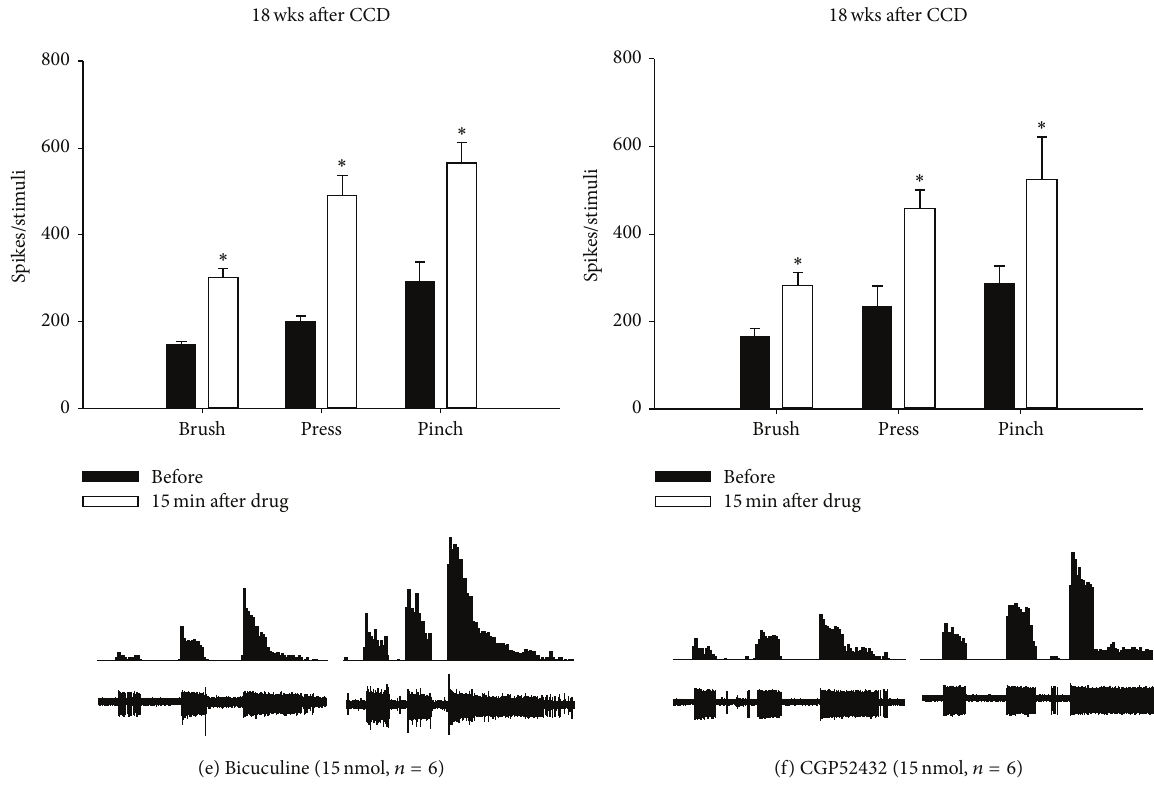
Figure 5: The effects of inhibition or activation of spinal GABA receptors on WDR neuronal activity following CCD. In sham-operated animals, topical application of bicuculline ((a), 15 nmol) or CGP52432 ((b), 15nmol) enhanced the activity of spinal WDR neurons evoked by brushing, pressing, and pinching stimuli. On 1 week after CCD, topical application of muscimol ((c), 5 nmol) or baclofen ((d), 25 nmol) attenuated the enhanced evoked activity of WDR neurons. On 18 weeks after CCD, bicuculline ((e), 15nmol) or CGP52432 ((f), 15nmol) led to an increase in evoked activity of WDR neurons. Data were expressed as the mean number of spike discharges generated from a single WDR neuron evoked by three types of 10s mechanical stimuli. Below each bar graph, examples of extracellular recordings of stimulus-evoked spike discharges from a single WDR neuron (lower rows) and of peristimulus time histograms for visualizing the rate of spike discharges (upper rows) are shown. ∗ 𝑃 < 0.05 when compared with predrug